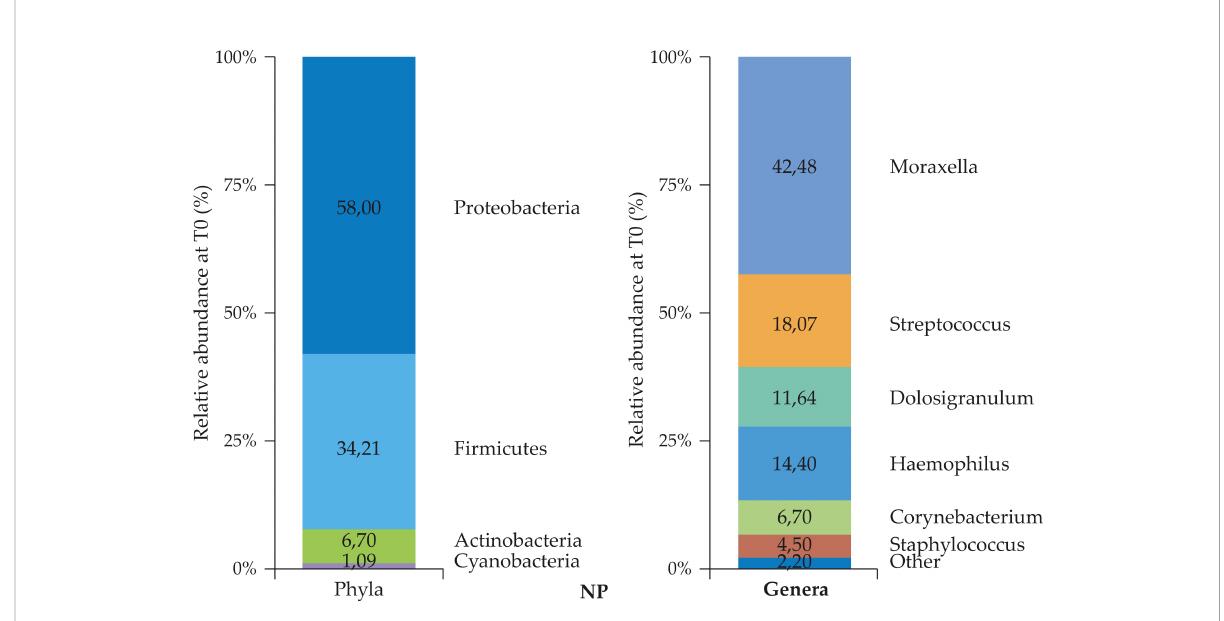
FIGURE 4 NP microbiota pro fi les (phyla and genera) in the total “ NP sample ” ( n = 158) at